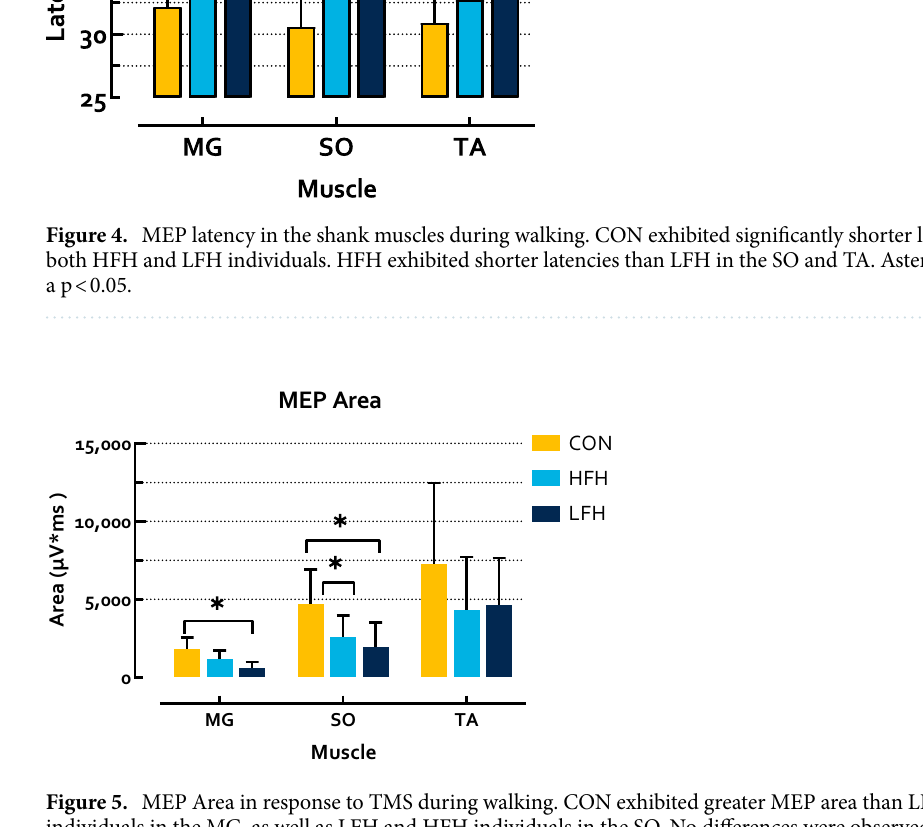
Figure 5. MEP Area in response to TMS during walking. CON exhibited greater MEP area than LFH individuals in the MG, as well as LFH and HFH individuals in the SO. No differences were observed in the TA. Asterisks denote a p <